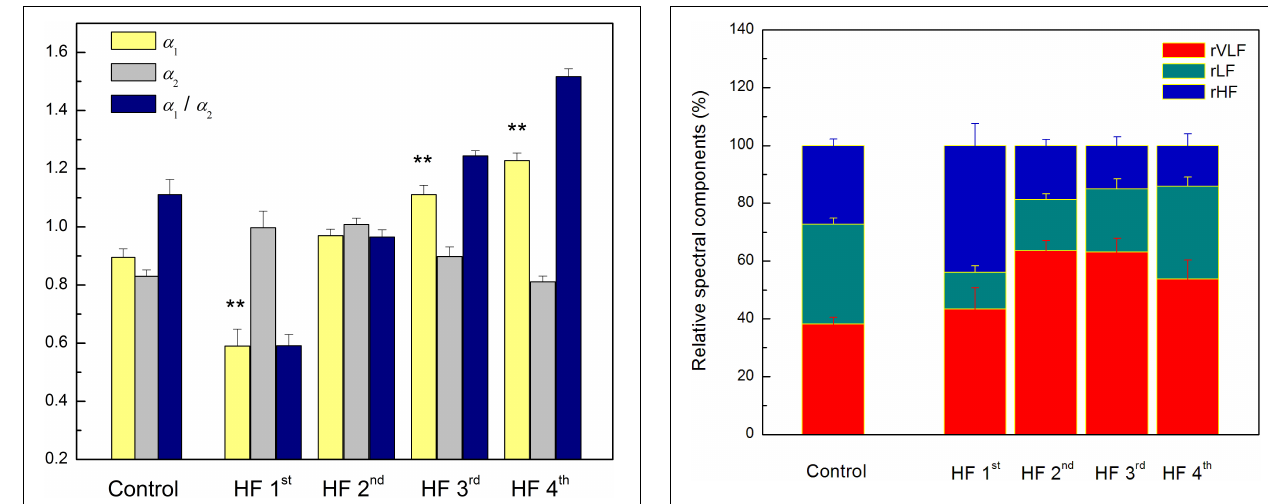
FIGURE 3 | Mean values plus standard errors of short-term scaling exponent ( α 1 ), long-term scaling exponent ( α 2 ) and their ratio α 1 / α 2 in control group and four clusters of heart failure patients. ∗∗ p < 0.01 ( α 1 vs. α 2 ). Short-term scaling exponent ( α 1 ) values were significantly different between control group and three clusters (1st, 3rd, and 4th), p < 0.01. Long-term scaling exponent ( α 2 ) values were significantly different between control group and two clusters (1st and 2nd), p < 0.01. The ratio α 1 / α 2 was significantly different between control group and two clusters (1st and 4th), p < 0.01, and with tendency toward statistical significance with the 3rd cluster ( p = 0.07). After comparisons only between clusters for α 1 we obtained following significances: (1st vs. 2nd, 1st vs. 3rd, and 1st vs. 4th, p < 0.01) and (2nd vs. 3rd, and 2nd vs. 4th, p ≤ 0.01). For α 2 we obtained: (1st vs. 4th, p < 0.01) and (2nd vs. 3rd, p = 0.06 and for 2nd vs. 4th, p < 0.01). For the ratio α 1 / α 2 all comparisons were statistically significant ( p < 0.01).